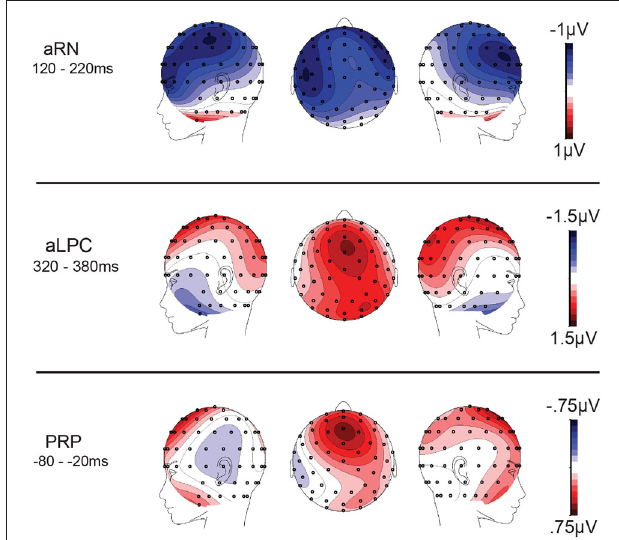
FIGURE 5 | Grand-averaged difference wave topographies (reversal minus stable) for each of the components of interest, averaged across the indicated time windows . As in Figure 4 , time zero refers to